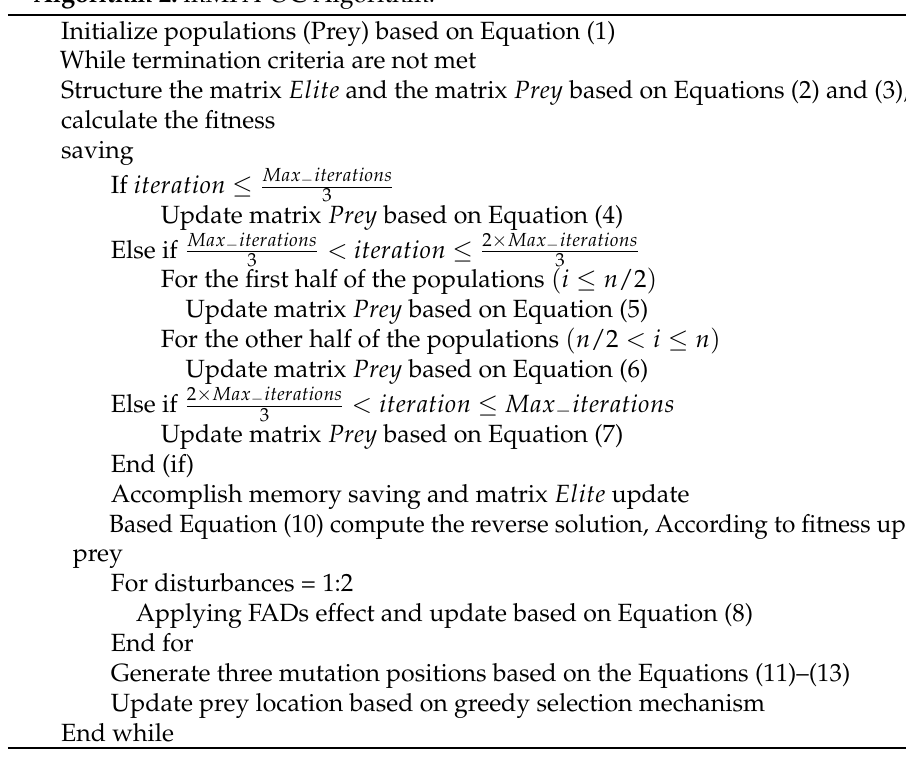
Algorithm 2: mMPA-OC